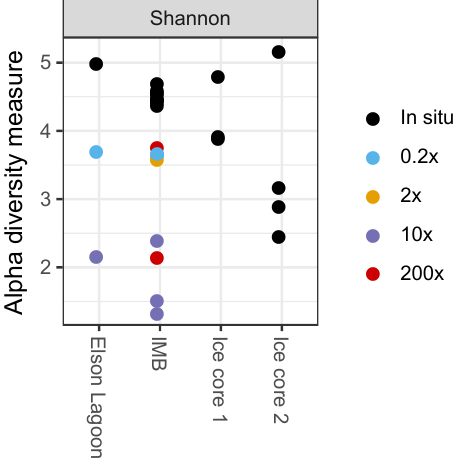
Figure 3. Shannon indices of alpha diversity for V4-V5